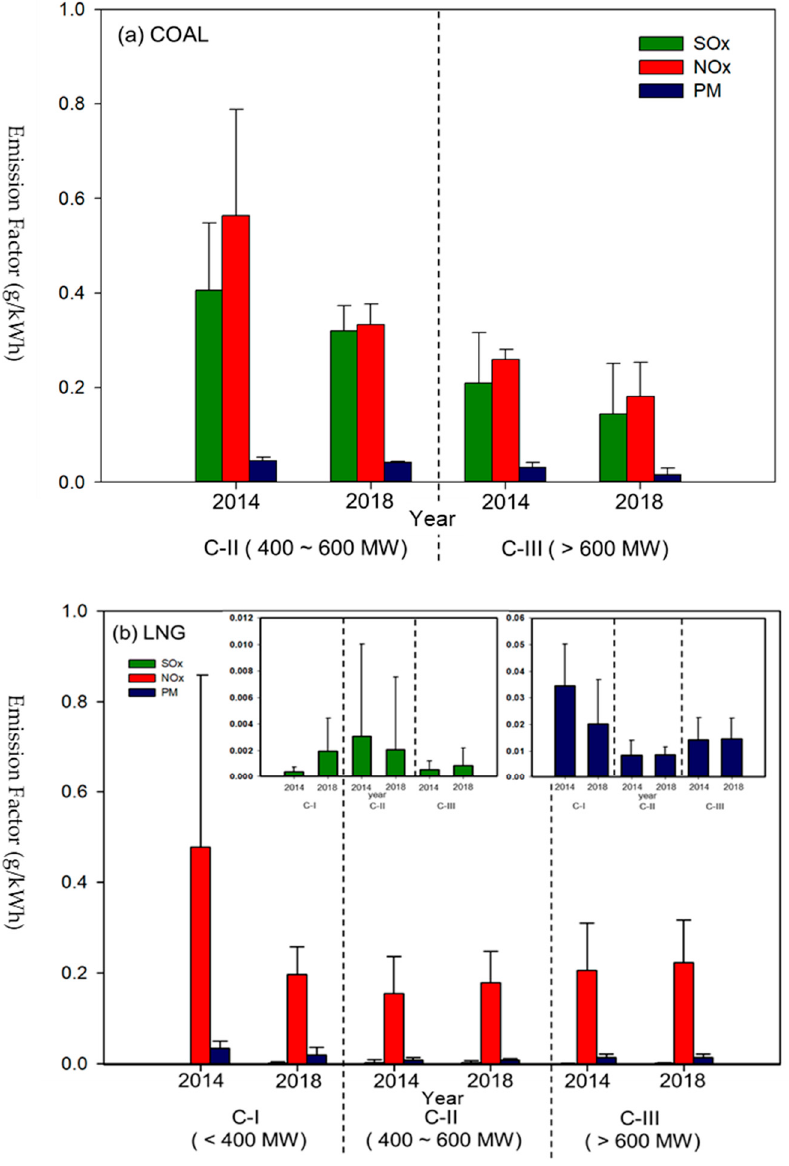
Figure 5. SOx, NOx, and PM emission factors for coal- and LNG-fired power generation units based on capacity at 2014 and 2018.